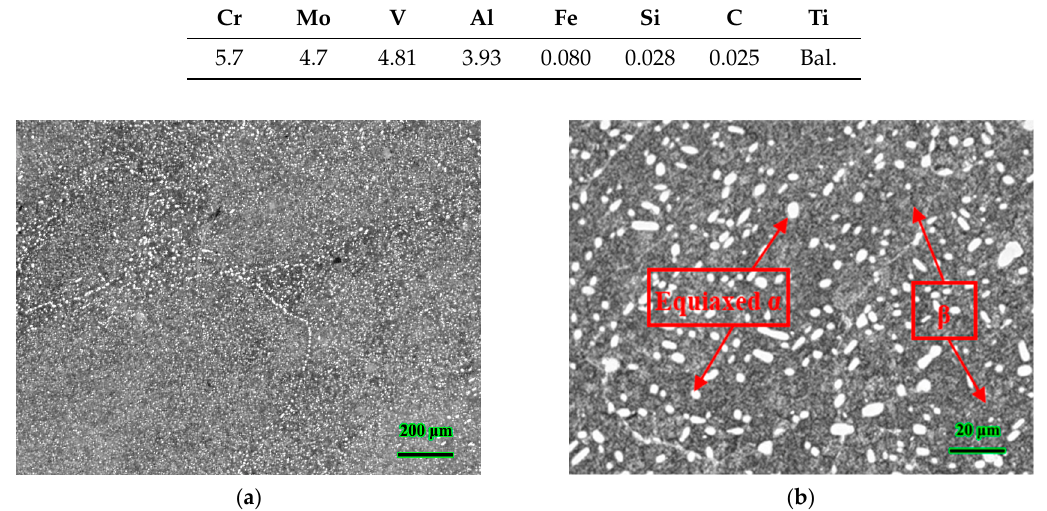
Figure 1. The initial microstructure of Ti-6554 alloy bar. ( a ) Microstructure at 50 × magnification; ( b ) Microstructure at 500 × magnification.